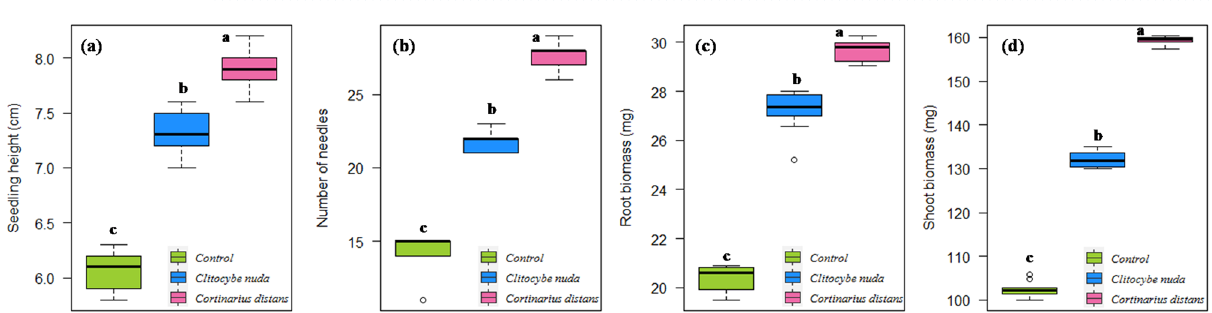
Figure 3. Boxplots showing effect of ECM inoculation on seedling growth traits ( a ) seedling height, ( b ) number of needles, ( c ) root biomass, and ( d ) shoot biomass of Abies pindrow . [Box: Tukey box with lower hinge of the box representing first quartile (Q 1 or 25th percentile), middle horizontal bold line representing median (Q 2 or 50th percentile), and upper hinge of the box representing third quartile (Q 3 or 75th percentile); Whiskers: Maximum (Q 4 or 100th percentile) and minimum (Q 0 or 0th percentile) values excluding outliers; Small circles: Outlier values; Different letters on the boxes indicate that the means are significantly different (Tukey’s HSD test, P < 0.05)].